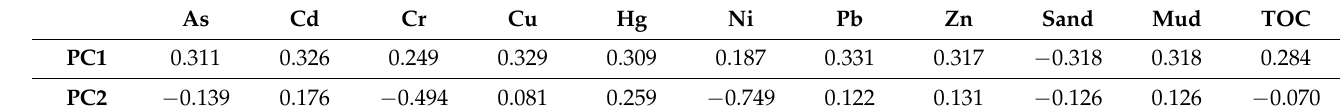
Table 2. Factor matrix obtained by principal components analysis (PCA).